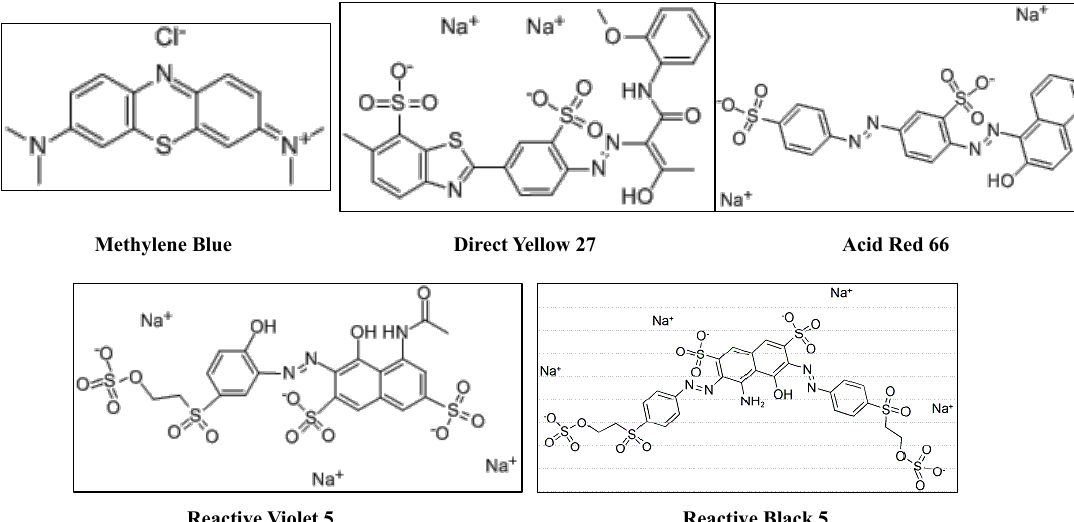
Figure.1 Various dyes used molecular structure Figure 1. Various dyes molecular